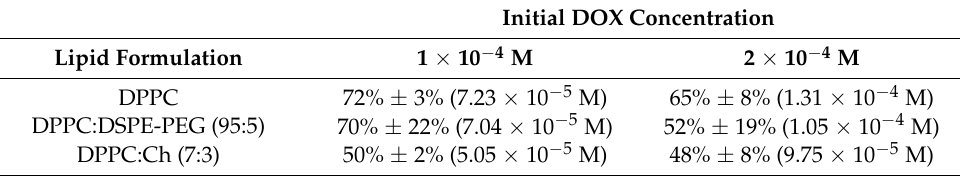
Table 5. Encapsulation efficiency, EE (%), and corresponding encapsulated DOX concentration, in solid magnetoliposomes containing Ca 0.25 Mg 0.75 Fe 2 O 4 at different concentrations of DOX. Standard deviation is from triplicate drug encapsulation